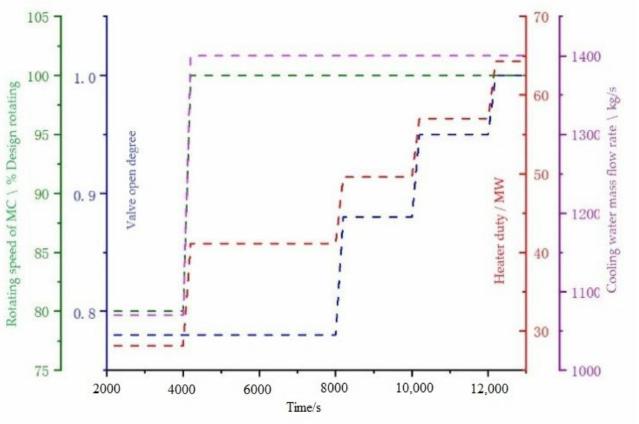
Figure 9. Changes of the parameters in the working load increase